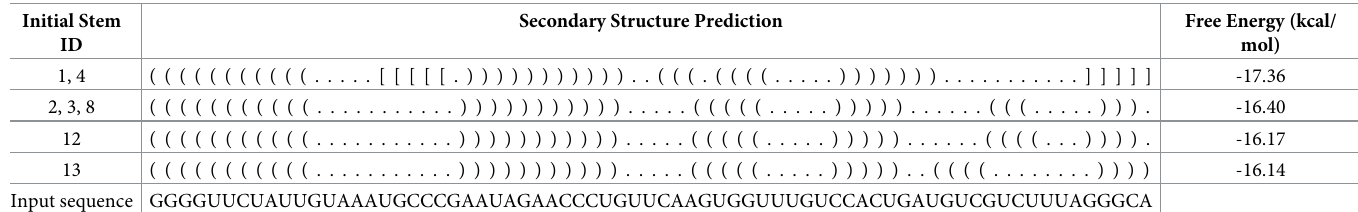
Table 7. Top four lowest free energy secondary structures predicted for MERS-CoV − 1 PRF stimulating pseudoknot based on the reference sequence. These struc- tures are predicted by Iterative HFold given the input stems in Table 6 as structural constraints. Input sequence is provided in the bottom row. See Table E in S1 File for the complete